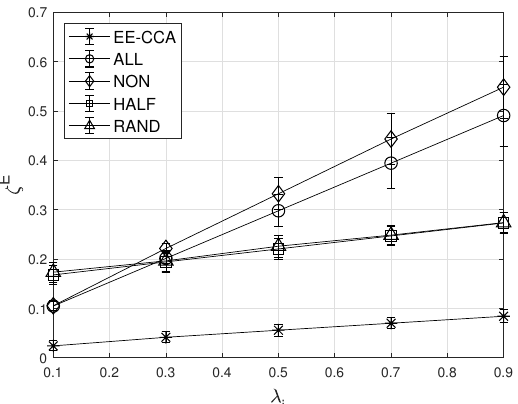
Figure 5. Effect of the inter-task occurrence rate on the average energy outage probability.